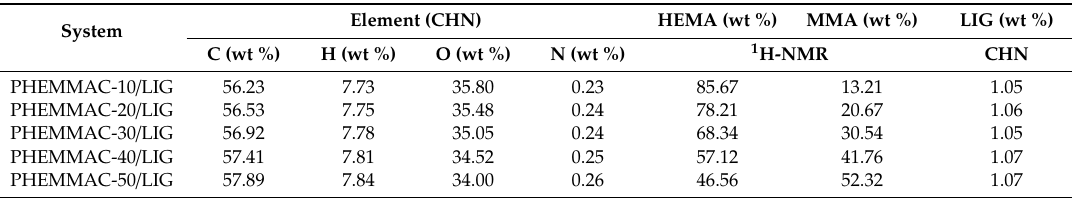
Table 3. Compositions of the poly(2-hydroxyethyl methacrylate-co-methyl methacrylate) crosslinked (PHEMMAC) / LIG system determined by CHN and 1